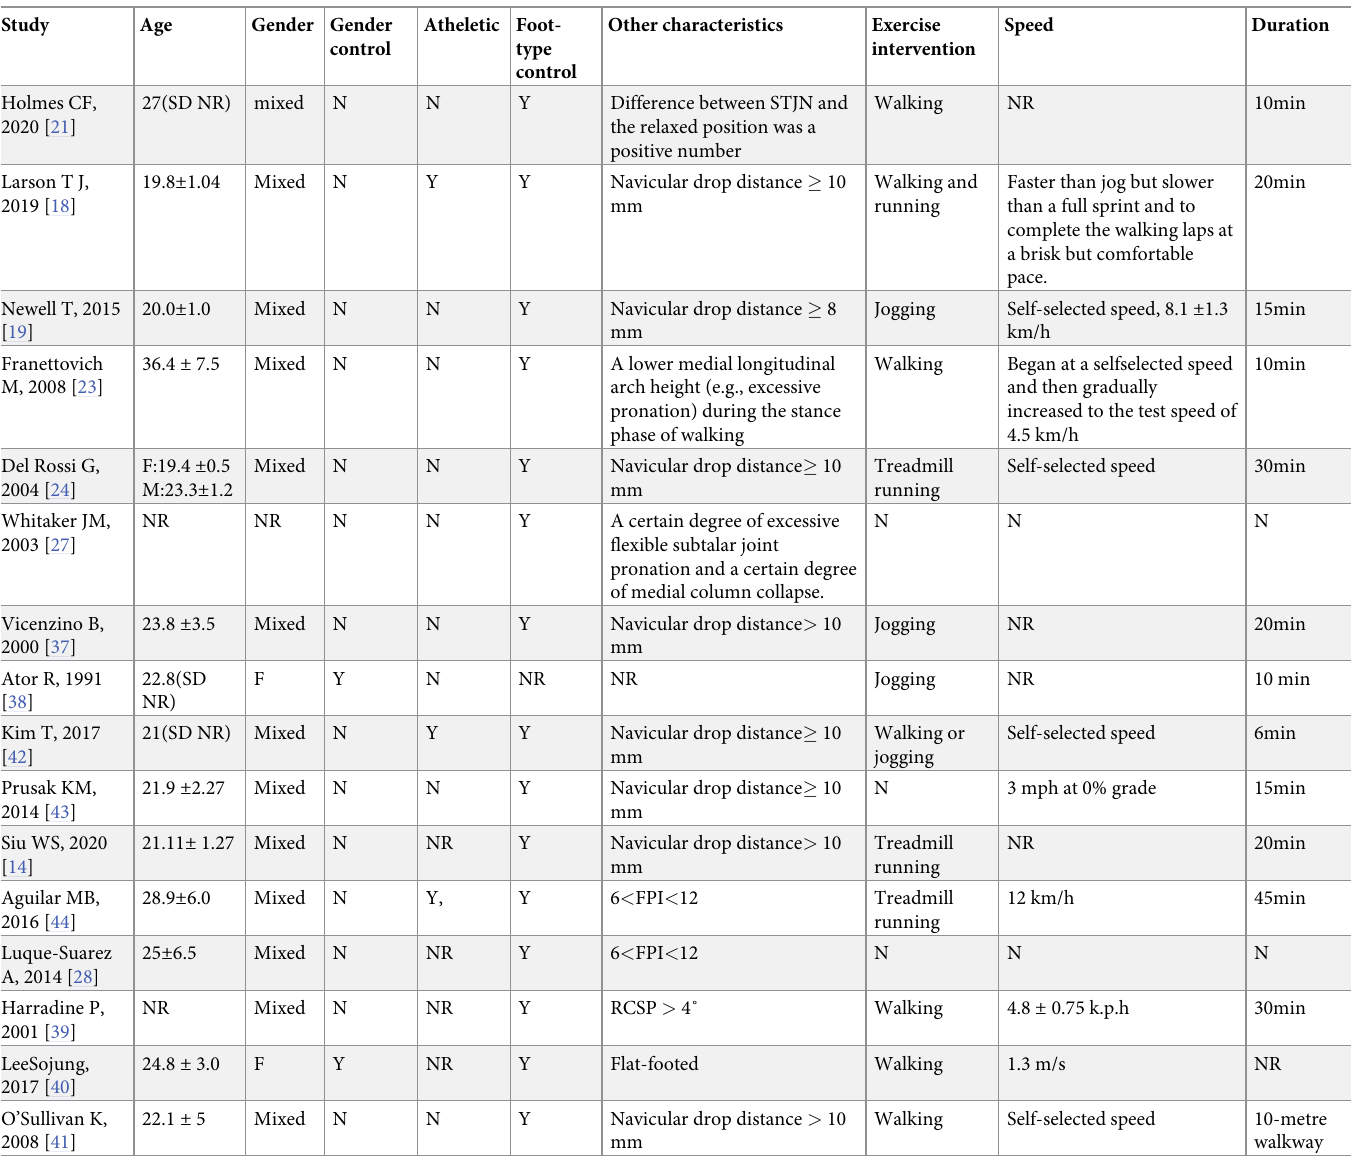
Table 2. Characteristics of participants in the included